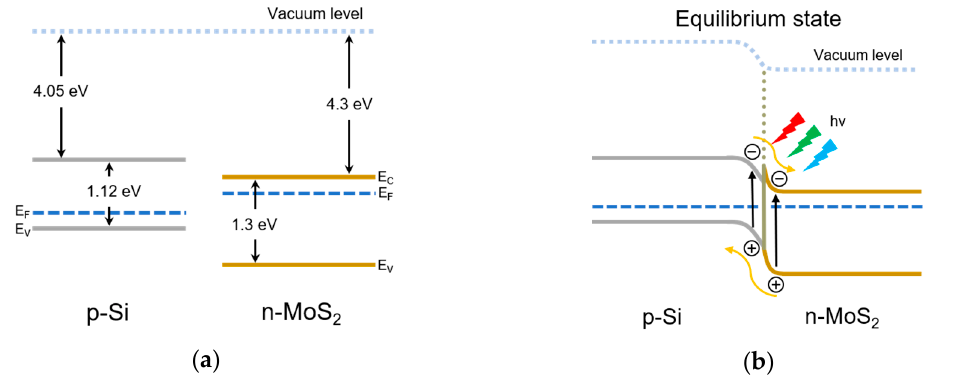
Figure 4. ( a ) p-type silicon and n-MoS 2 energy band diagrams. ( b ) The energy band diagram of n-MoS 2 / p-Si heterojunction in equilibrium state.